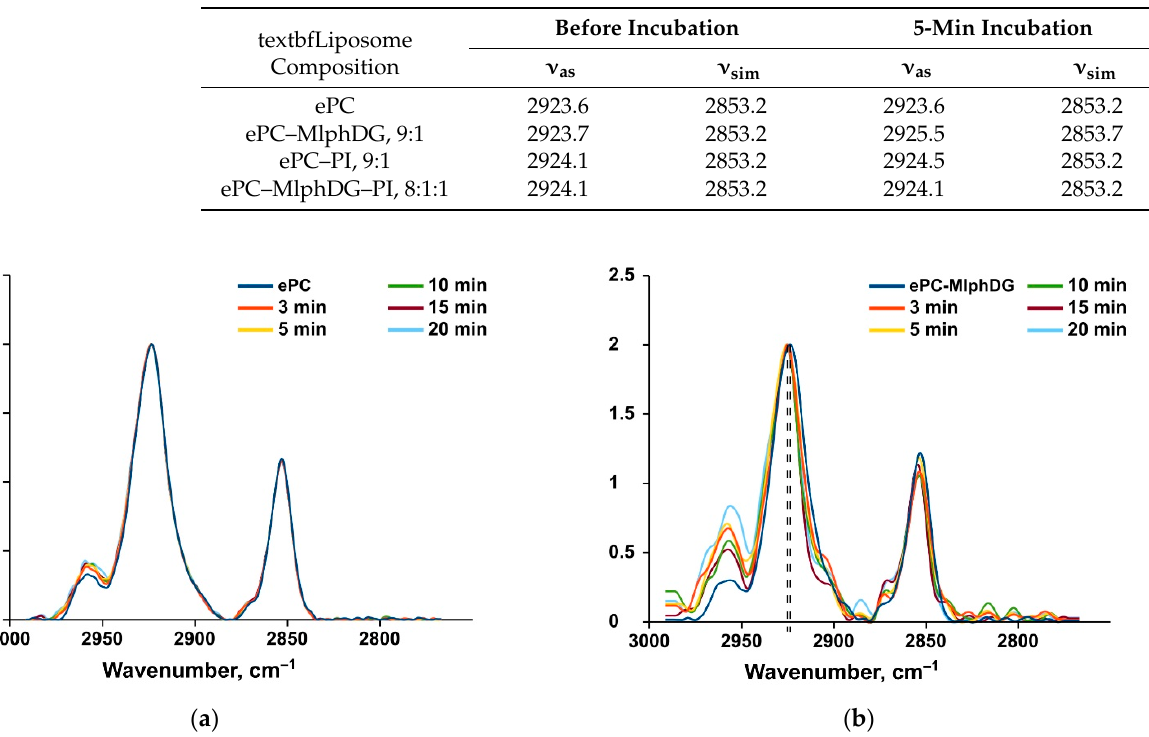
Figure 5. Examples of FTIR spectra. Methylene peaks for the ePC ( a ) and ePC–MlphDG ( b ) liposomes alone and upon their incubation with BSA. Dashed lines show the peak shift for the ePC–MlphDG liposomes upon the addition of albumin.